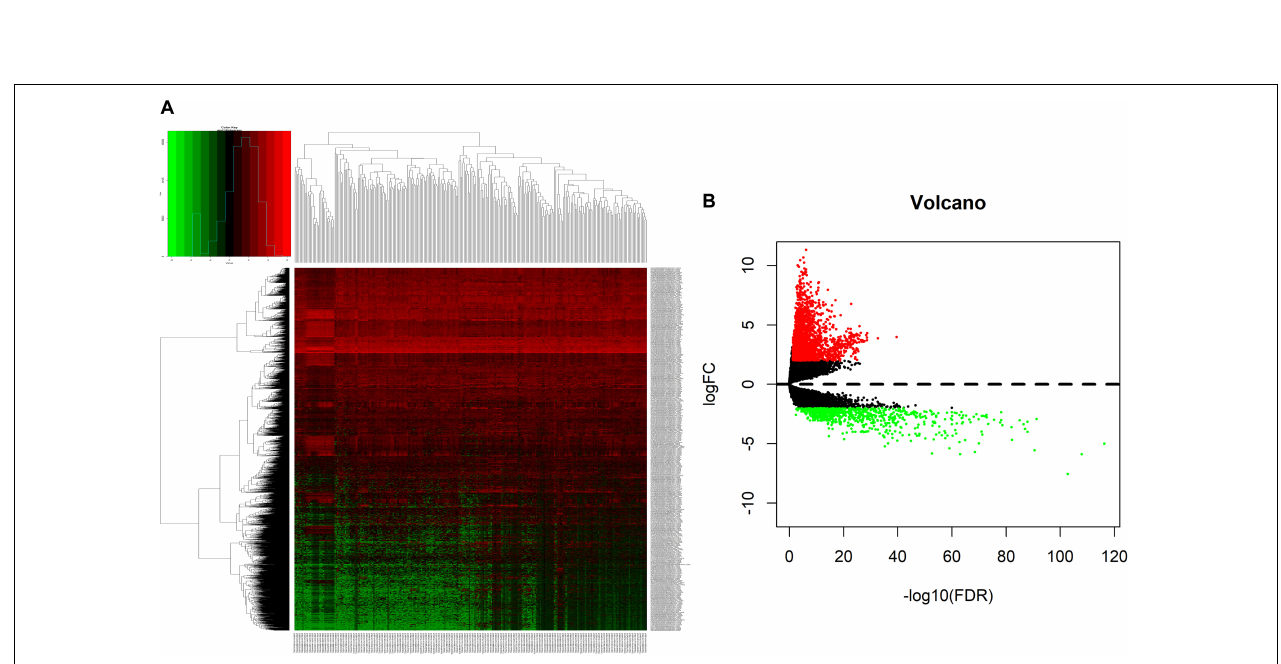
FIGURE 3 | Identification of differentially expressed mRNAs in LUAD and normal tissues. (A) The heatmap of genome-wide differentially expressed mRNAs. (B) The volcano plot showed that a total of 2055 upregulated mRNAs and 674 downregulated mRNAs were screened out. Green and red represents downregulated and upregulated mRNAs, respectively. mRNAs, messenger RNAs; LUAD, lung adenocarcinoma.